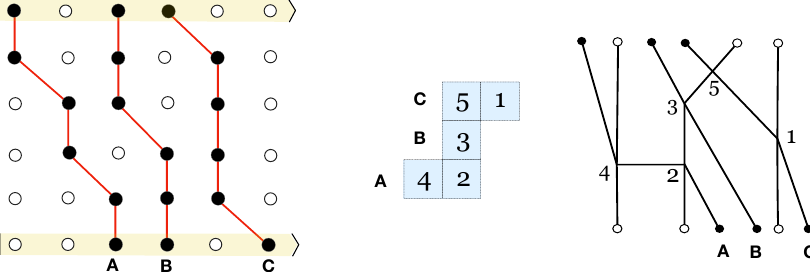
Figure 4 . Left : a possible way of hopping of m = 3 hard magnons — labelled as A, B, C — from a certain initial to final state with empty spaces among magnons. Center : the standard skew Young tableaux corresponding to this process. Right : graph representation of the process: each magnon A, B, C hops left when crossing a vertical line. Vertices are numbered according to the order of